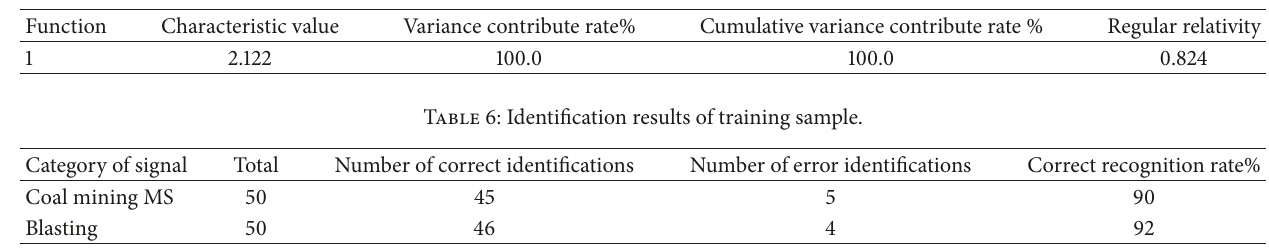
Figure 8: Comparison of discriminant results of three classifiers and single characteristic. Table 5: Eigenvalue of discriminant analysis.